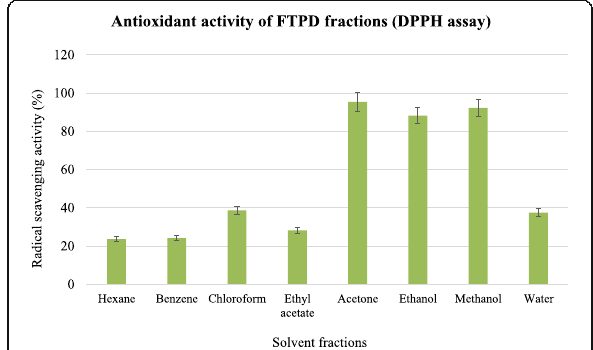
Fig. 5 Antioxidant activity shown by solvent fractions of fermented tea petal